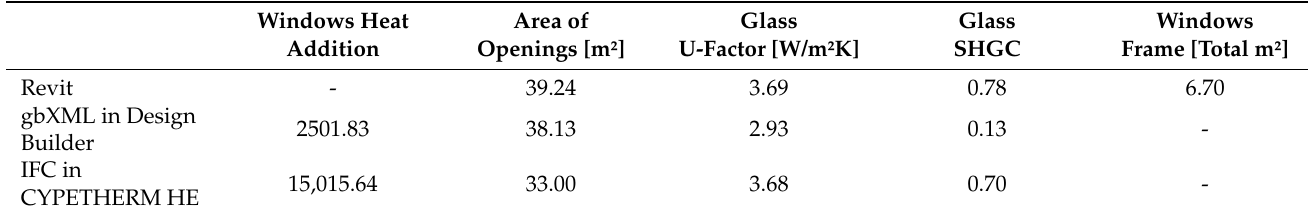
Table 5. Window properties.